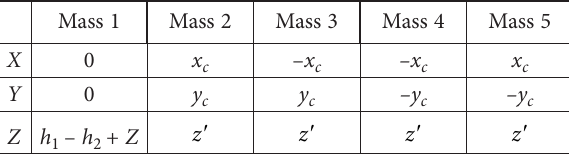
Table 1. The coordinates of the centers of gravity point masses Mass 1